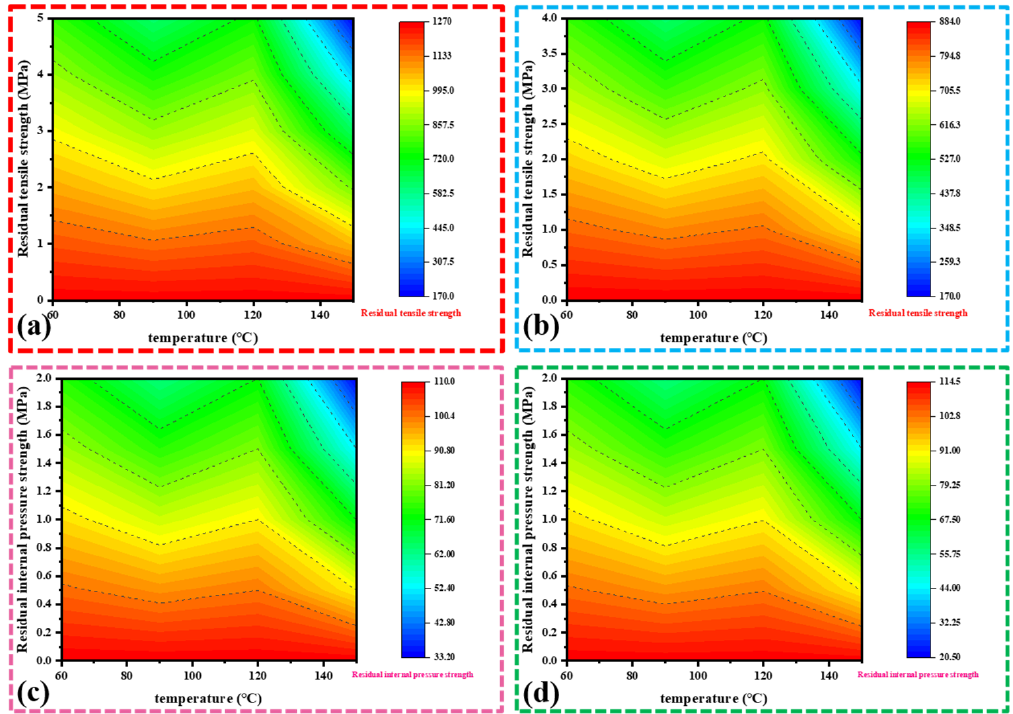
Figure 19. Residual tensile strength of T95 steels considering pitting corrosion: 0–2000 m; 2000–4700 m (( a , c ): Residual tensile strength and Residual internal pressure strength in gas phase; ( b , d ): Residual tensile strength and Residual internal pressure strength in liquid phase).